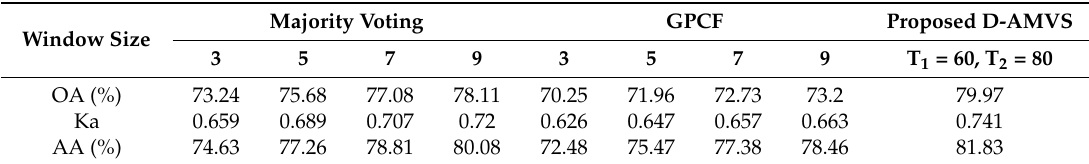
Table 4. Comparison of the proposed D-AMVS and different post-classification approaches for the Pavia University image. GPCF: general post-classification framework.